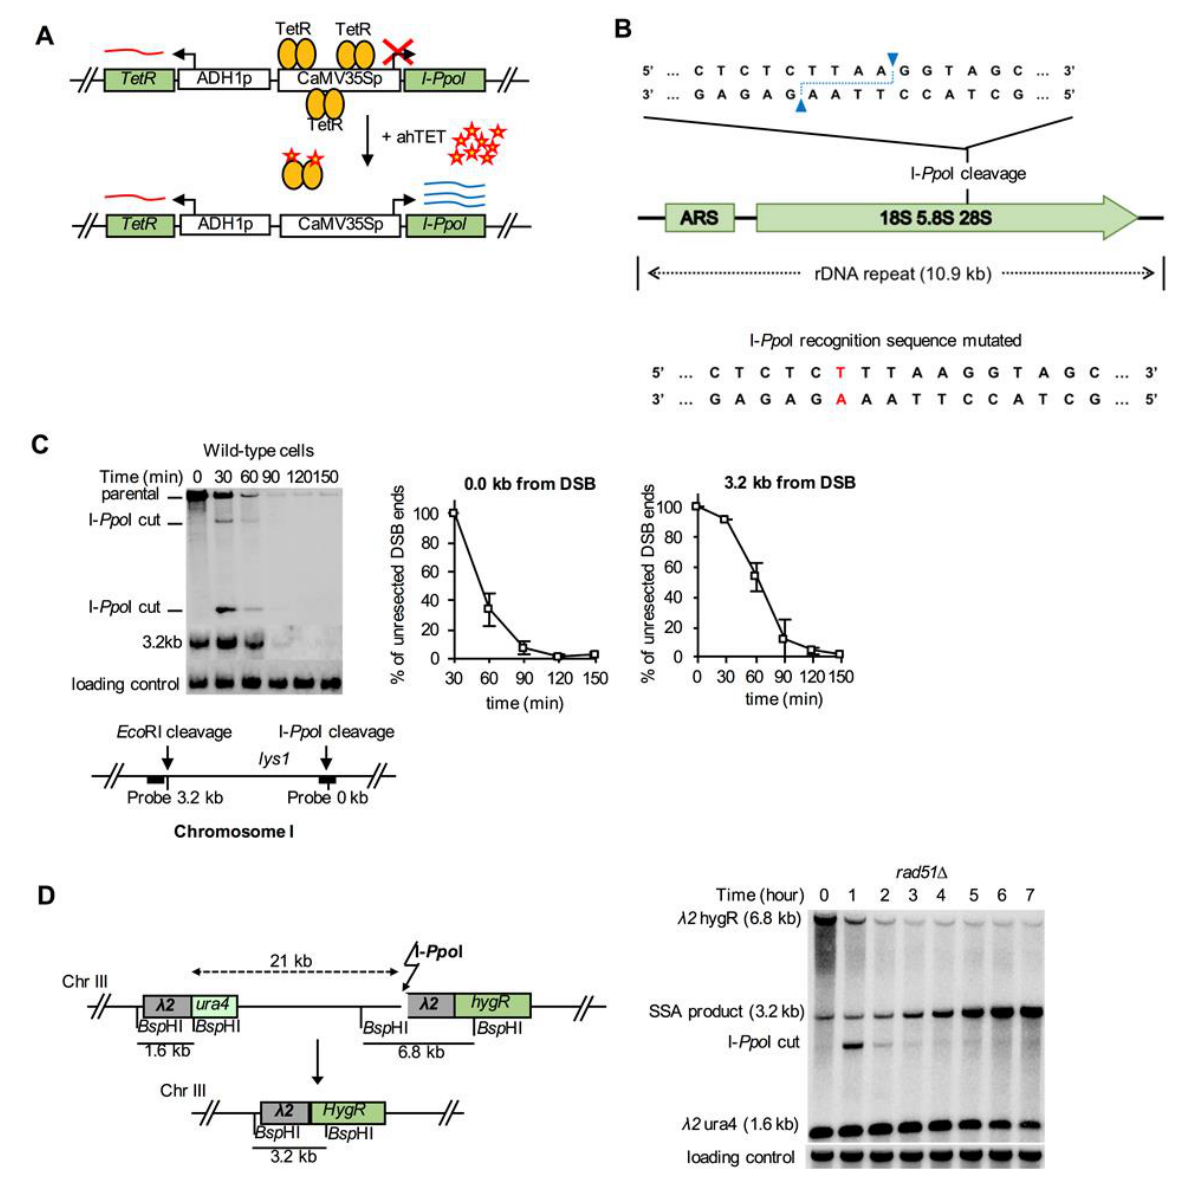
FIGURE 10: DSB induction and repair in fission yeast. (A) Inducible I- Ppo I system. I- Ppo I is under the control of an anhydrotetracycline (ahTET)-inducible promoter. The ADH1 promoter drives constitutive expression of a tetracycline repressor, TetR. TetR binds to and repress- es the promoter of the plant viral cauliflower mosaic virus 35S (CaMV35S) carrying three Tet operators (binding site for TetR). Addition of tetracycline inducer (yellow stars) inactivates TetR and thus activates I- Ppo I expression. (B) Diagram showing the I- PpoI recognition se- quence, cleavage site within rDNA and typical sequence change in cells resistant to I- Ppo I cleavage (ARS, autonomously replicating se- quence). (C) Analysis of DSB induction by I- Ppo I and resection by Southern blot, and quantification of kinetics of resection at DSB ends and at 3.2 kb from the DSB. Diagram shows I- Ppo I cleavage site at the lys1 locus. (D) Diagram of the SSA assay between two partial lambda se- quences. Southern blot analysis of SSA. Lambda sequence was used as a